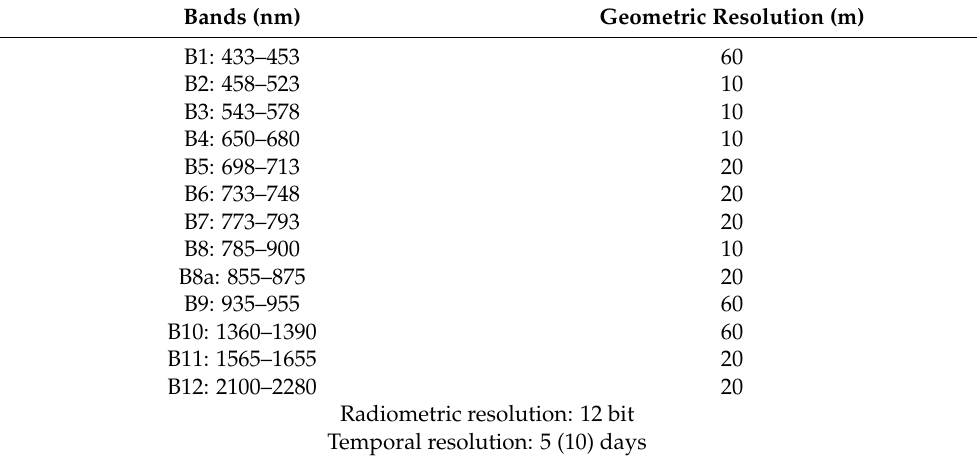
Table 2. Sentinel-2 Multi Spectral Instrument Technical characteristics.